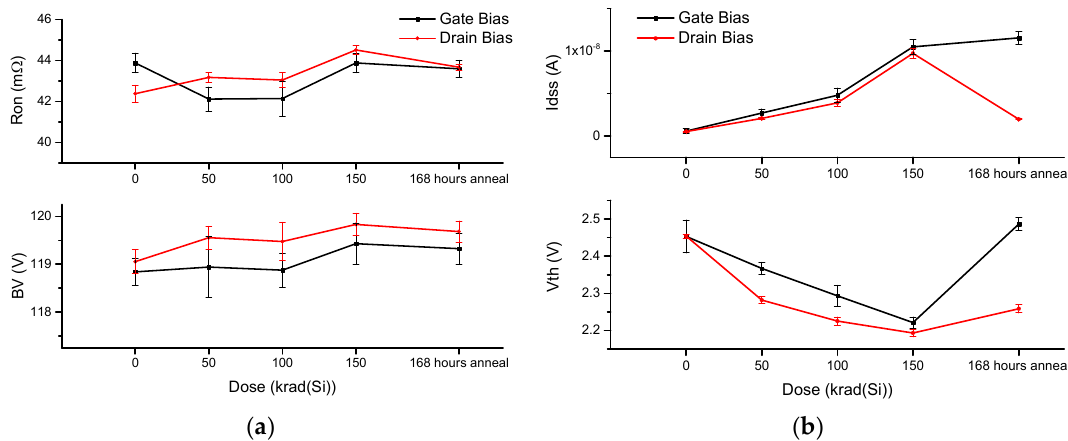
Figure 4. Parameters change with total ionizing dose (TID) dose and annealing time: ( a ) R on and BV dss ; ( b ) I dss and V th .